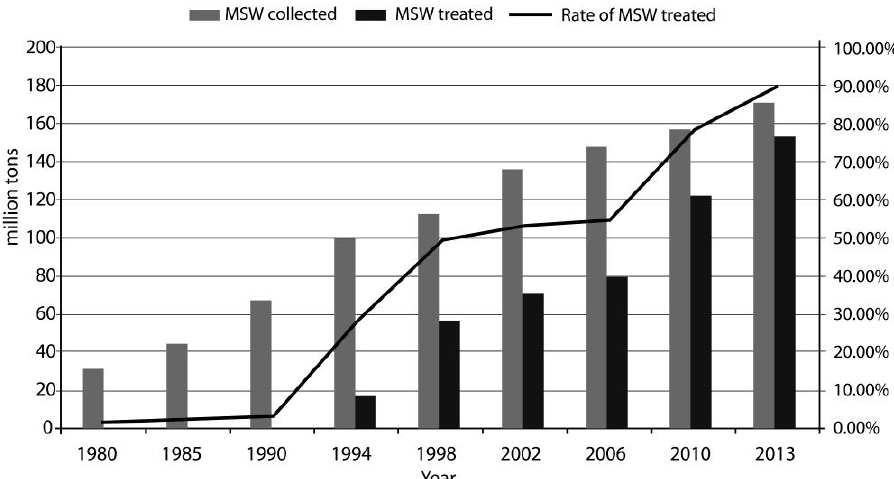
Fig. 12. Municipal solid waste (MSW) management in China (1980-2013)(Source: Zhang et al.,